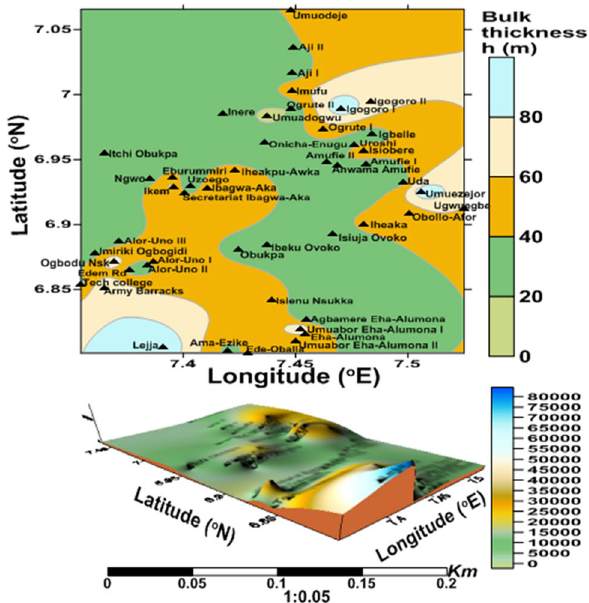
Fig. 6 2D and 3D contour map showing the variation of bulk thick- ness in the study area